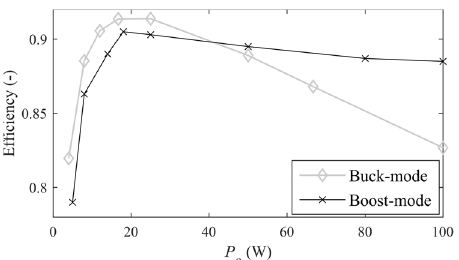
Figure 18. Step response from ( a ) R to RL and ( b ) R to RC.